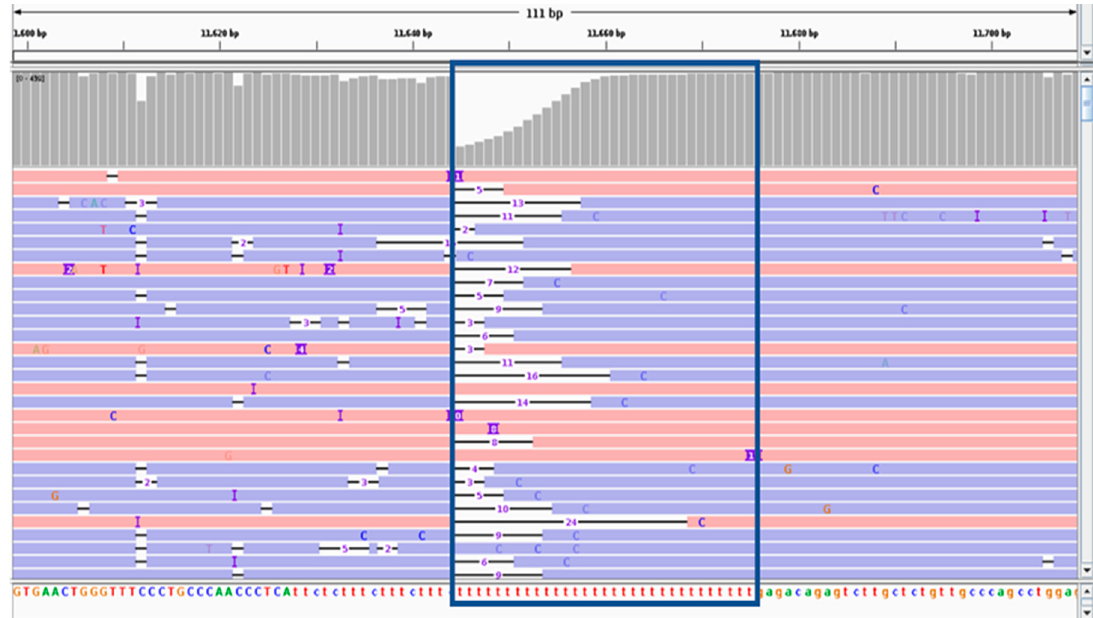
Figure 3. Integrative Genomics Viewer ( IGV) visualization of ONT mapped reads from sample V1 at position 11,658. IGV visualization showing a region where a homozygous SNV at position 11,658 was not identified based on ONT data. The blue box shows that the SNV occurs within a long homopolymer run.